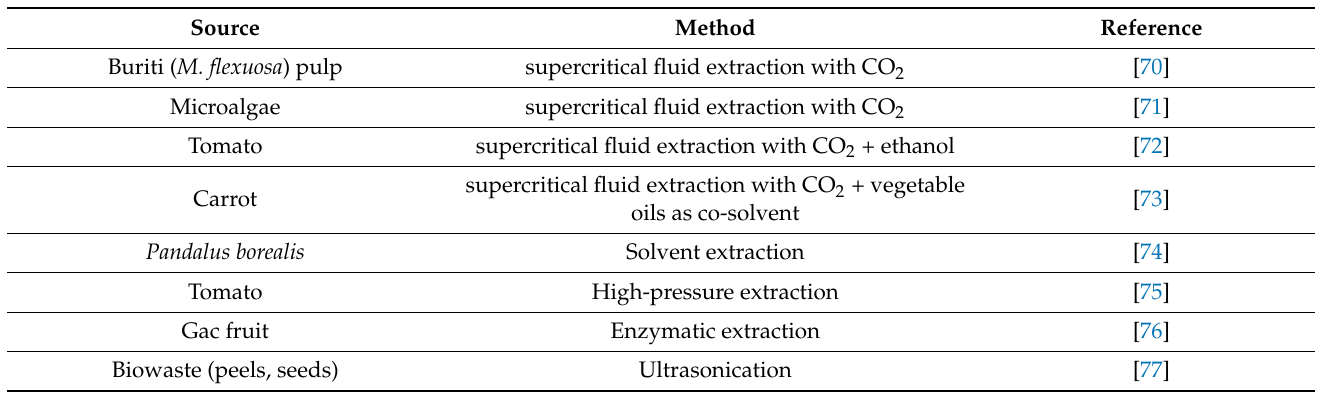
Table 2. Most common extraction methods for the recovery of carotenoids from natural